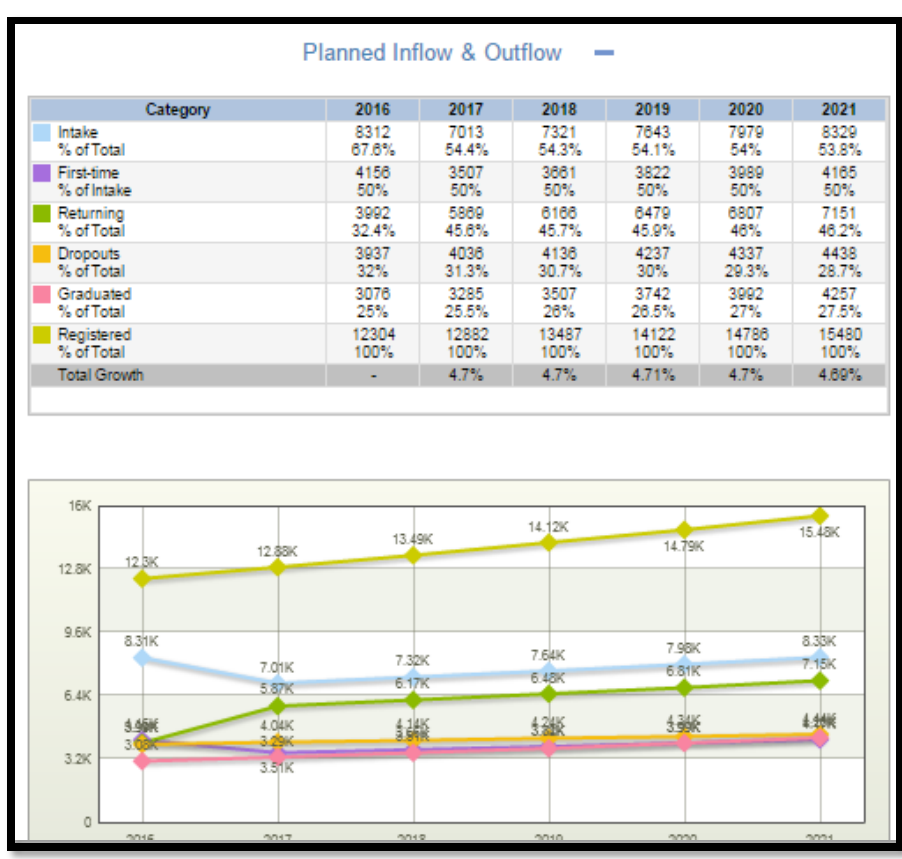
Figure 9. Excerpt qualification flow planning view - planned inflow and